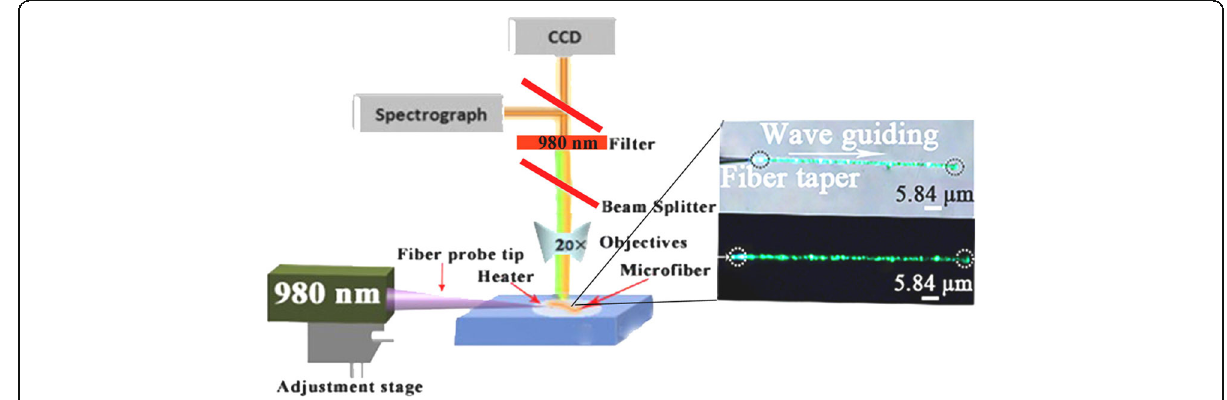
Fig. 2 Experimental setup of wave-guiding